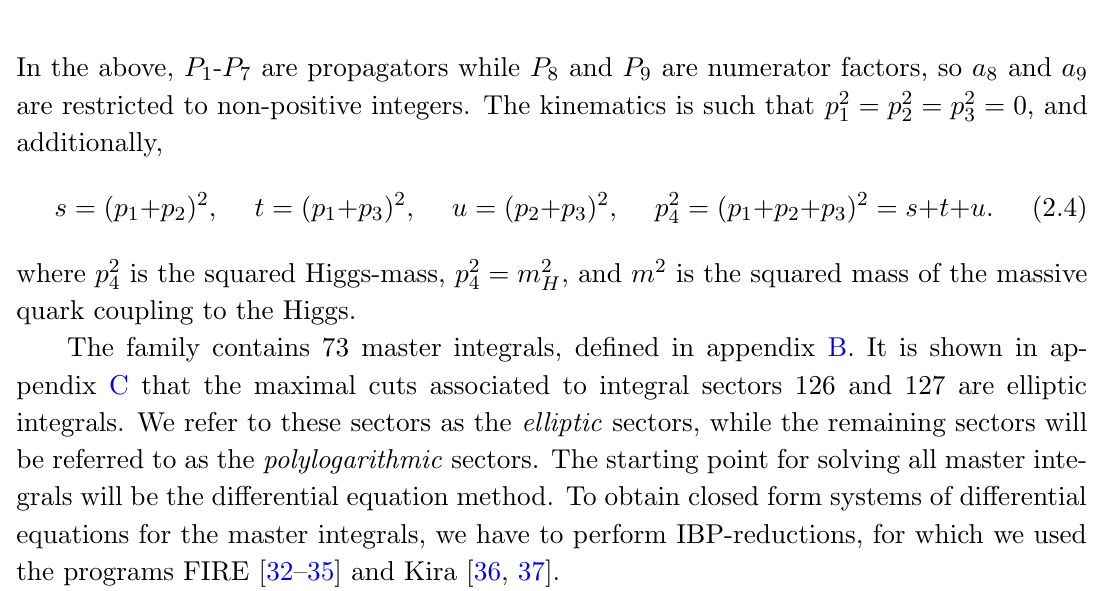
Figure 2 . The integral family F with momenta and propagator